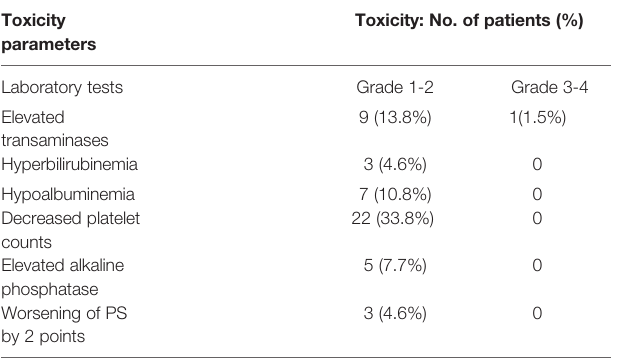
TABLE 2 | Toxicities after hypofractionated radiotherapy (5Gy*10f) based on TOMO. Toxicity parameters